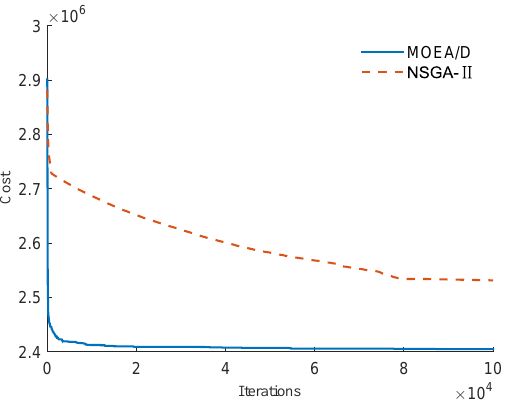
Figure 8. Convergence property of cost objective function with MOEA/D and NSGA ‐ II.